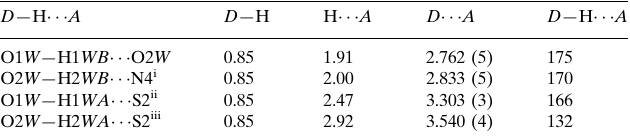
Hydrogen-bond geometry (A˚ , (cid:2)